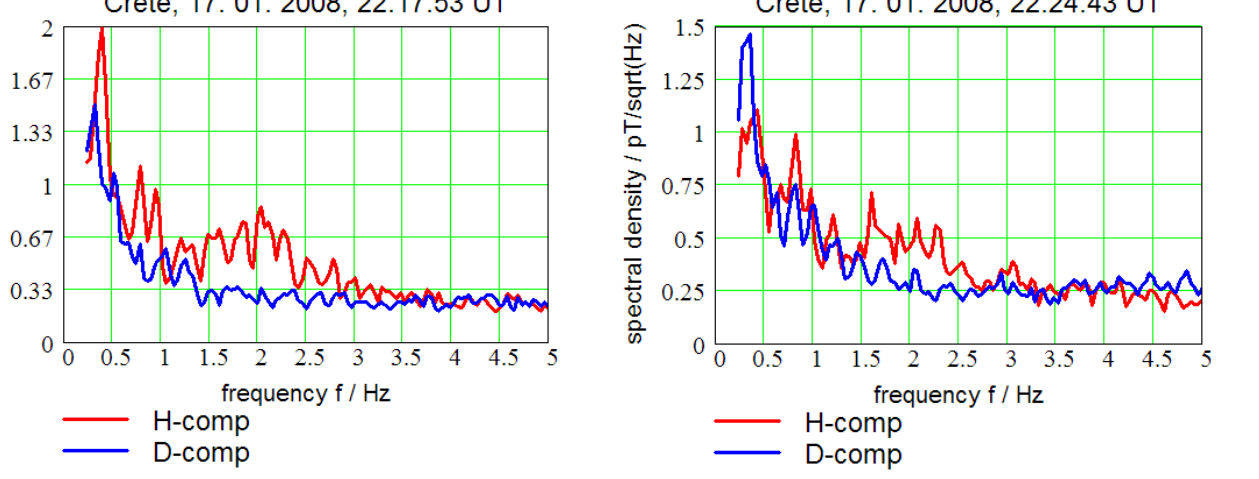
Fig. 6. Same as in Fig. 5 but for the next consecutive 410s time